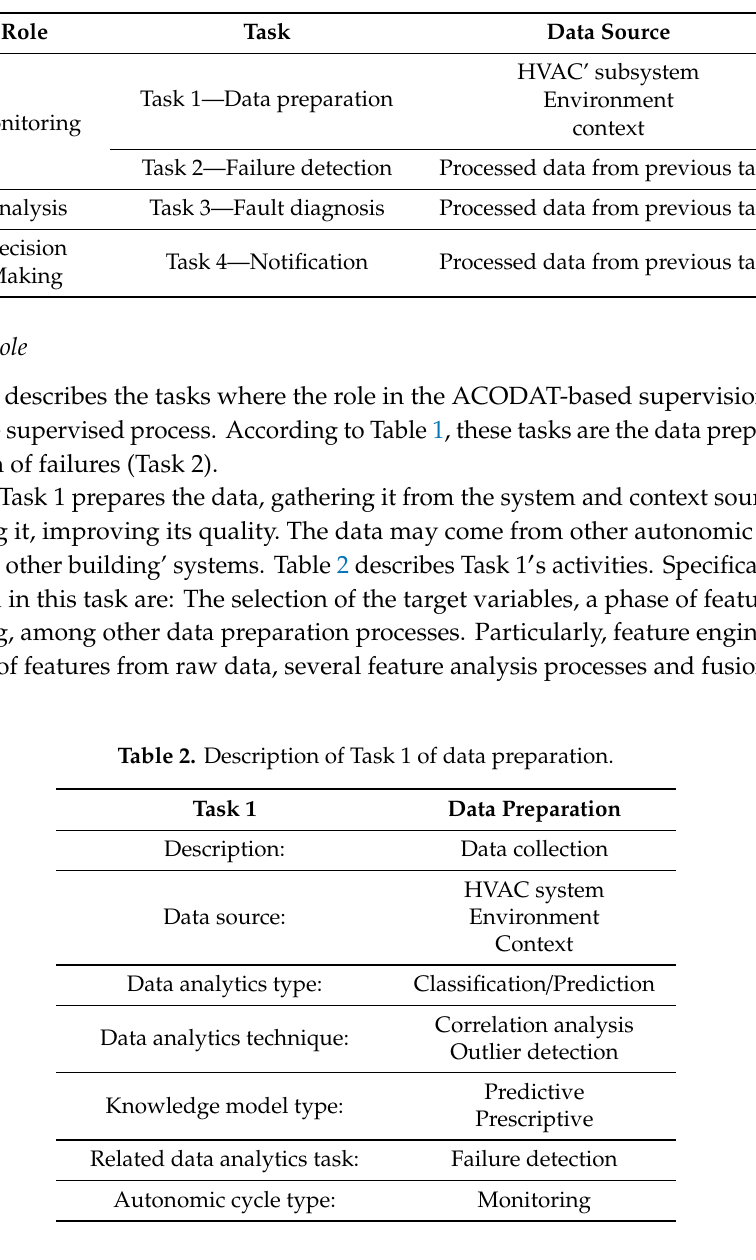
Table 1. ACODAT-based supervision tasks, roles and data sources for heating, ventilation and air conditioning (HVAC).